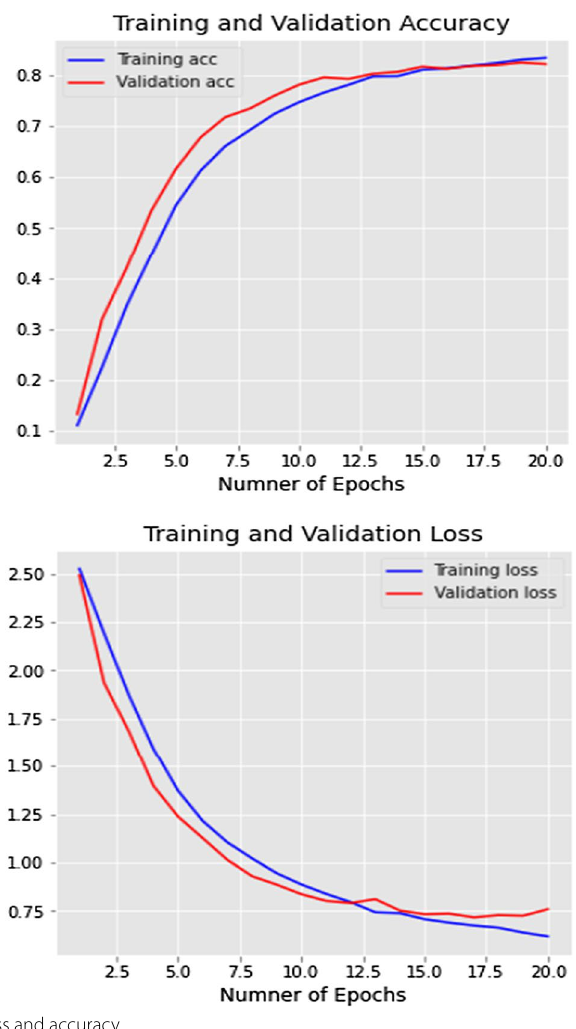
Fig. 5 Training loss and accuracy